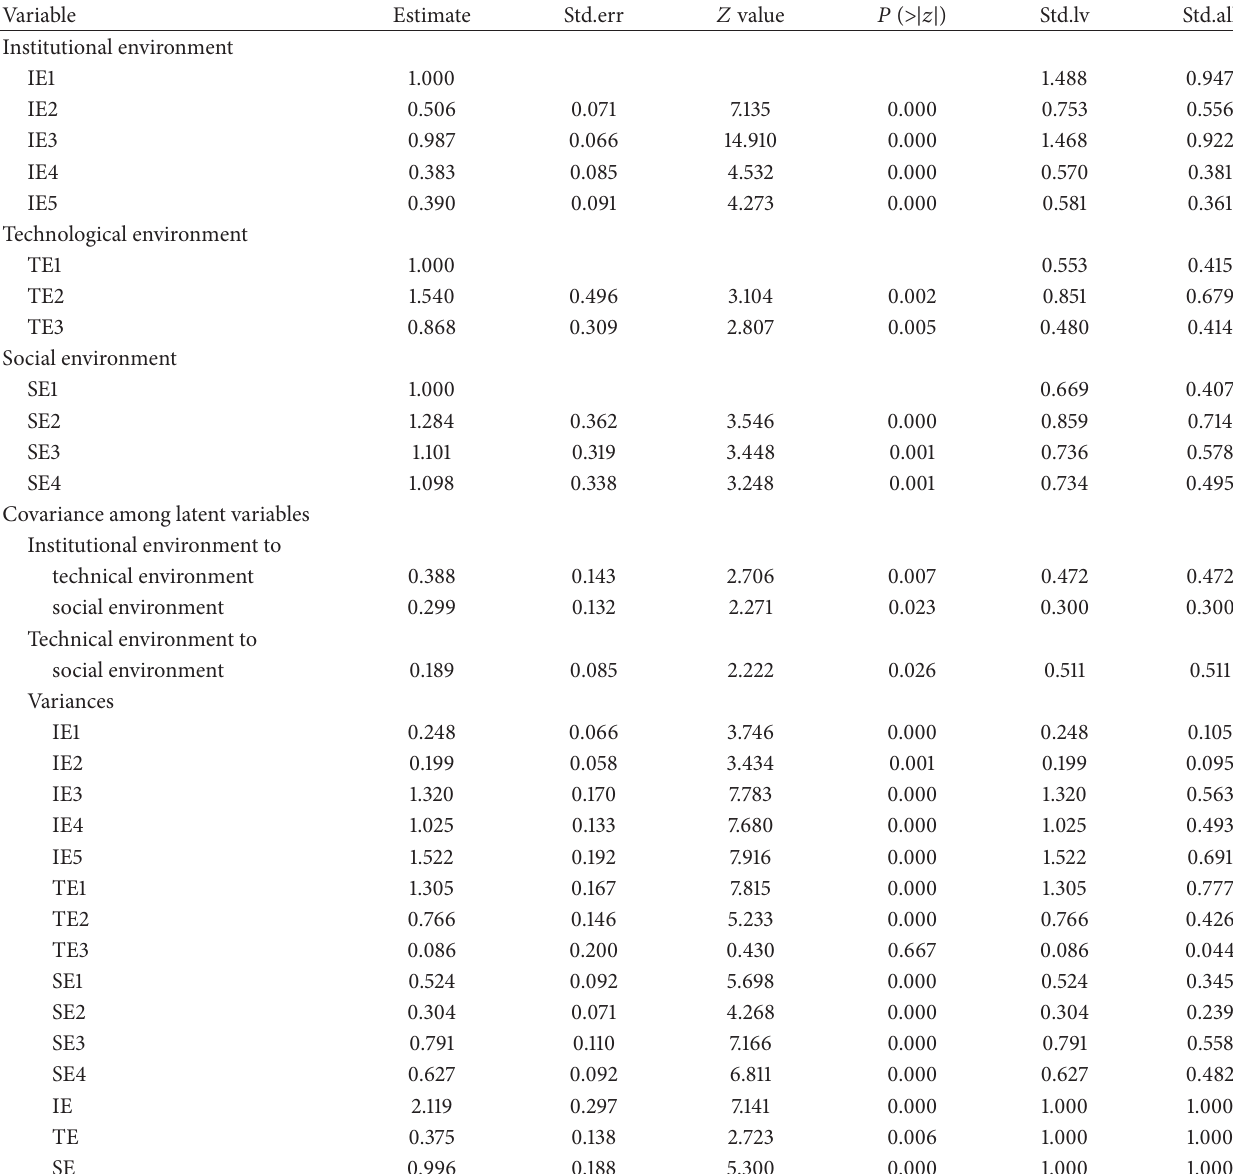
Table 3: Confirmatory factor analysis for Uganda on the institutional, technical, and social environmental variables